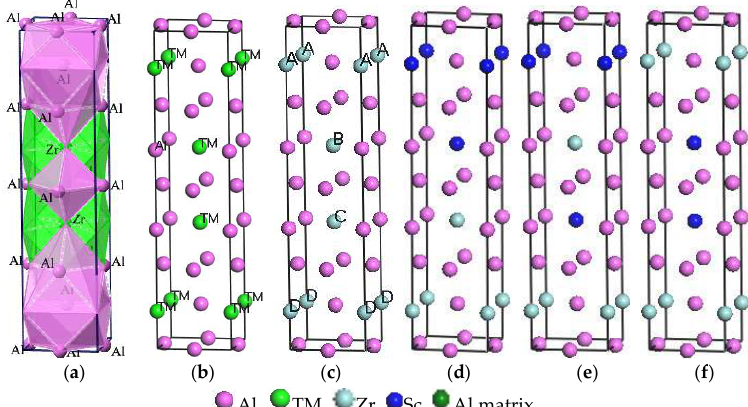
Figure 1. Crystal models. ( a ) Polyhedral model of Al 3 Zr; ( b ) Al 3 TM (TM = Ti, Zr, Hf, Sc); ( c ) Al 3 Zr(Al:Zr = 12:4); ( d ) Al 3 Zr(Sc2-1) (Al:Zr:Sc = 12:2:2); ( e ) Al 3 Zr(Sc2-2) (Al:Zr:Sc = 12:2:2); ( f ) Al 3 Zr(Sc2-3) (Al:Zr:Sc = 12:2:2).